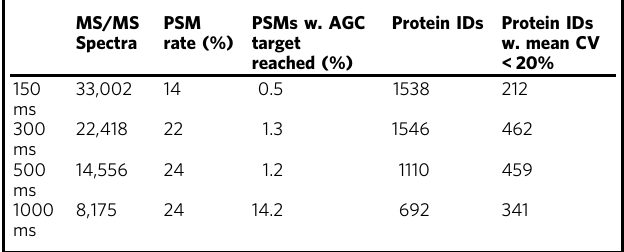
Table 1 Comparison of different IT settings using technical